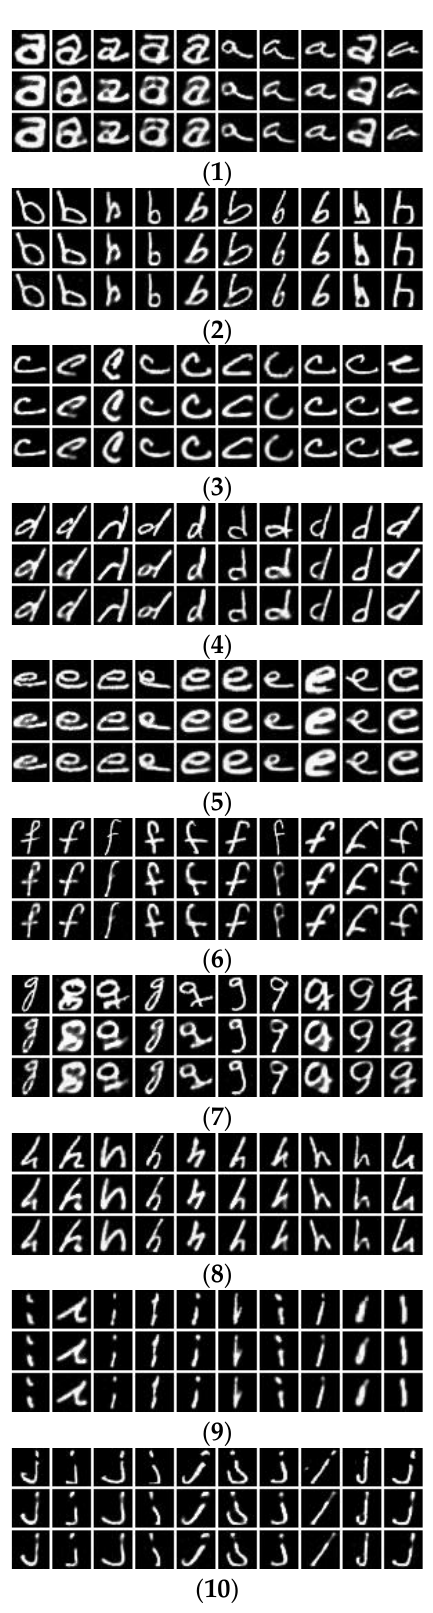
Figure 20. Reconstruction images on the EMNIST data set ( small letters ). For each subfigure, the top row exhibits the original images, the middle row exhibits the recovery images of AE, and the bottom row exhibits the recovery images of RCDAE.